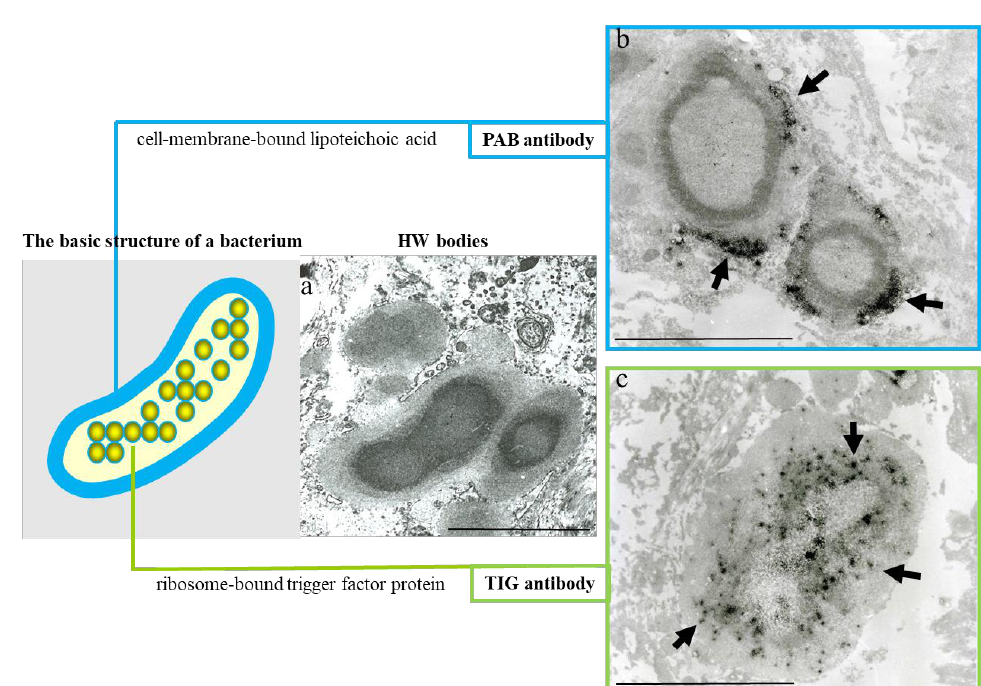
Figure 3. Evidence suggesting that HW bodies are cell-wall-deficient C. acnes . HW bodies lack a cell wall structure ( a ). Immunoelectron microscopic localization (black signals indicated by arrows) in HW bodies of two different C. acnes -specific bacterial components — cell-membrane-bound lipo- teichoic acid detected by the PAB antibody ( b ) and ribosome-bound trigger factor protein detected by the TIG antibody ( c ) — was consistent with their localization in the basic structure of a bacterium despite their lacking a cell wall structure. All photos are original and were previously published [18]. Scale bar: 5 μm.